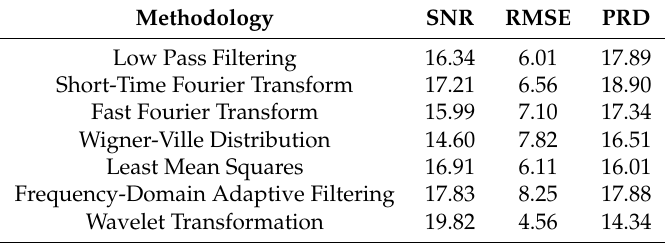
Figure 3. Inverese Discrete Wavelet Transform (IDWT). Table 1. Performance Comparison for Denoising